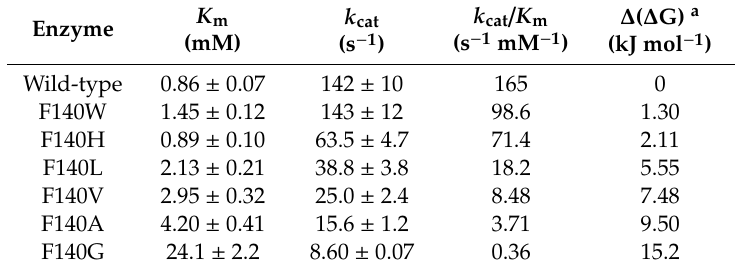
Table 1. Kinetic parameters of wild-type NitAF and mutants for hydrolyzing phenylacetonitrile.